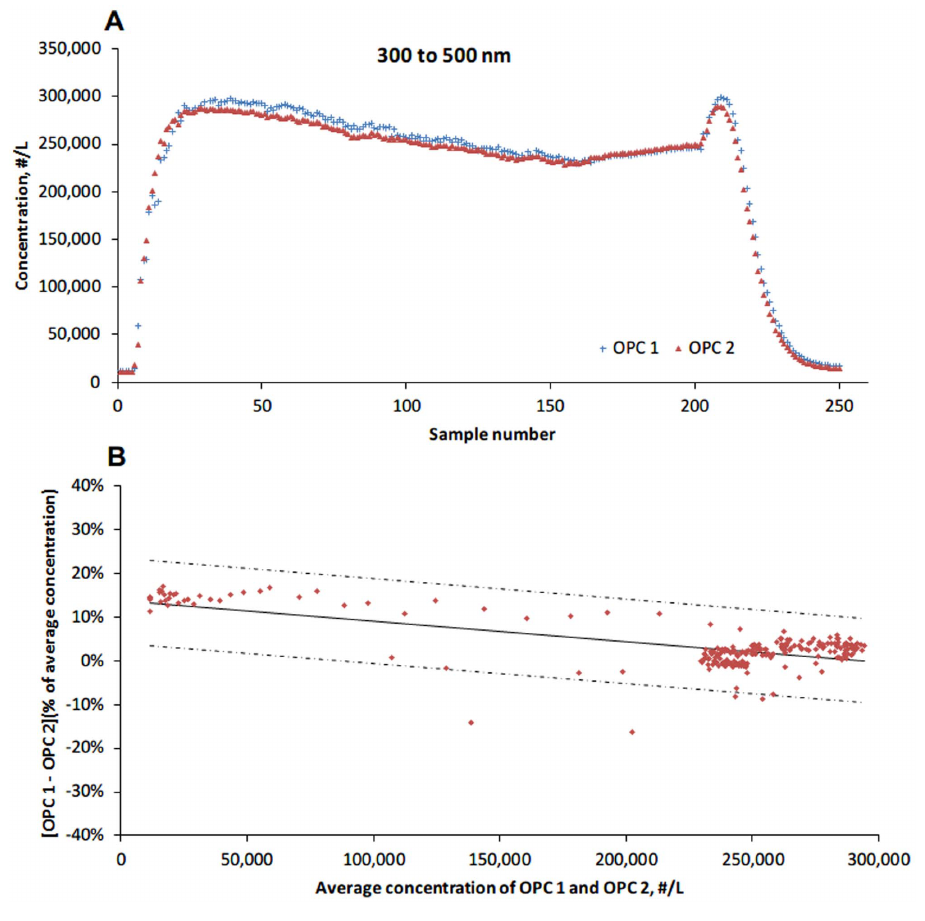
Figure 2. Comparison of 300 to 500 nm particle measurements by two Optical Particle Counters (OPCs). The solid lines indicate mean percent difference; the dot-dashed lines indicate 6 1.96 standardized deviations (SD) around the mean percent difference.